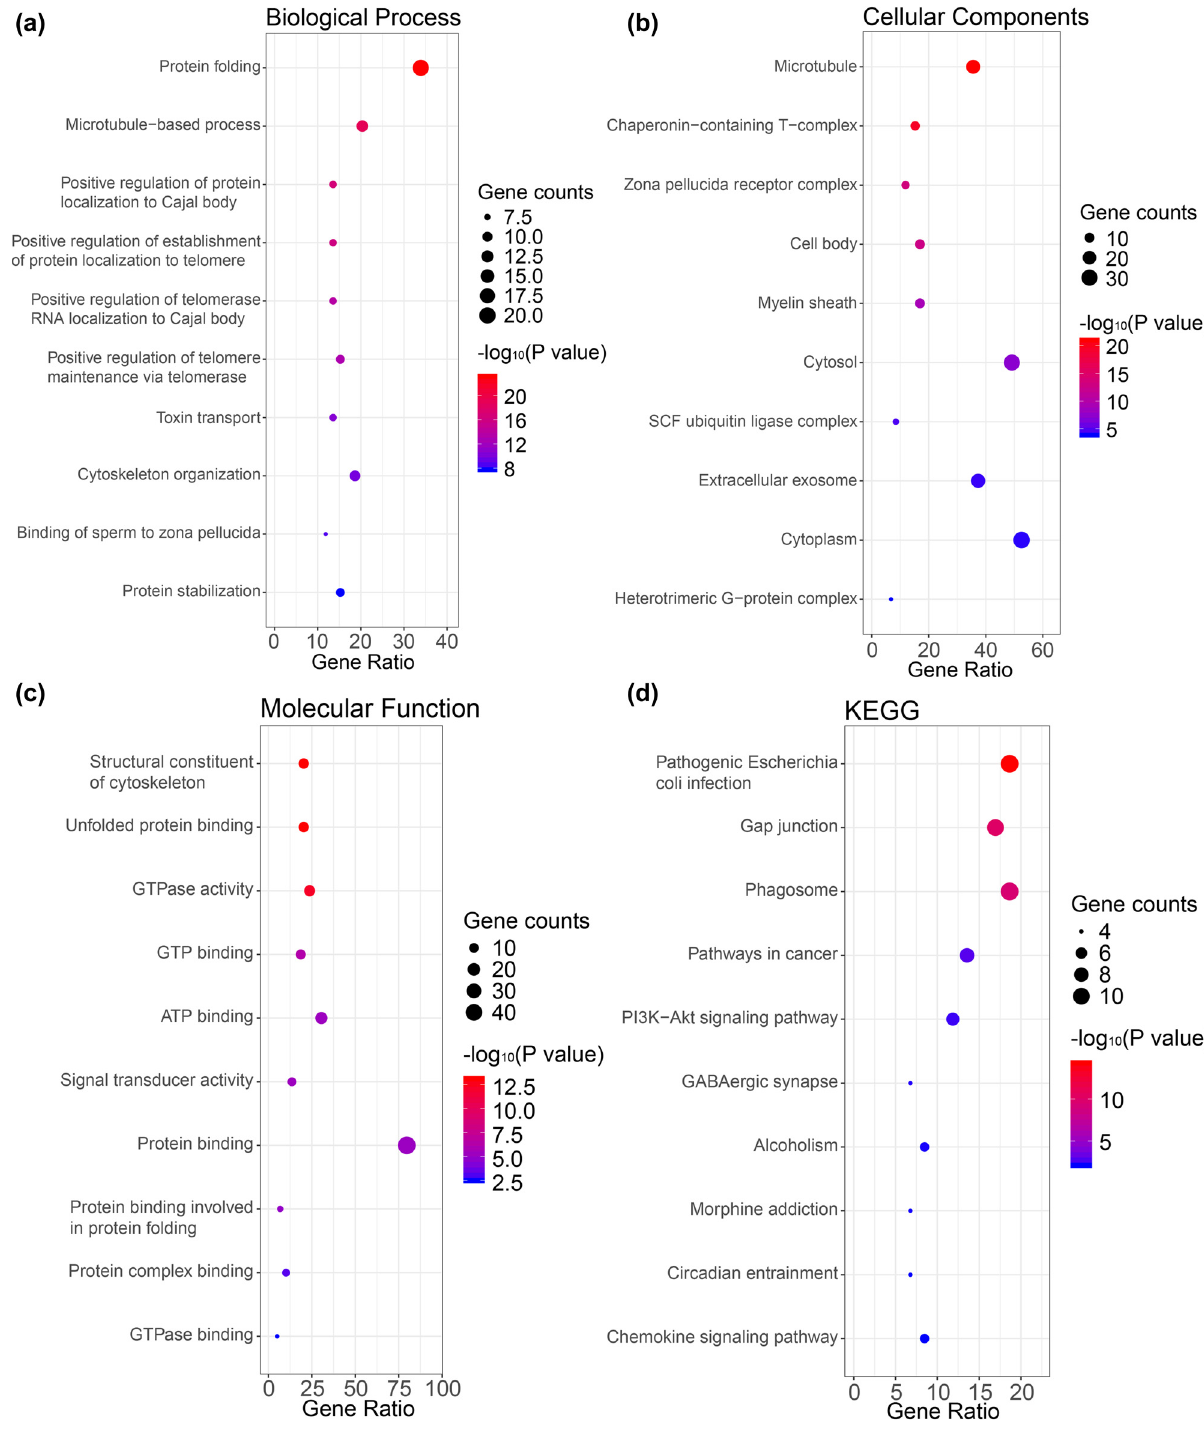
Figure 9: Functional enrichment analysis of CCTs and neighbor genes in HNSC. The bubble diagrams display the enrichment results of CCTs and top 50 genes altered in the CCTs neighborhood in HNSC. ( a ) Biological processes. ( b ) Cellular components. ( c ) Molecular functions. ( d ) KEGG